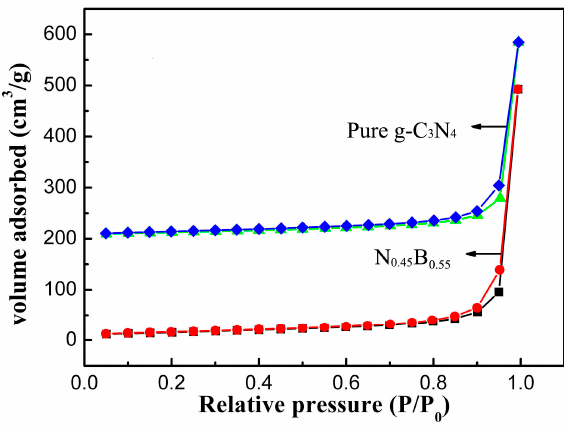
Figure 5. Nitrogen adsorption-desorption isotherms of the as-obtained g-C 3 N 4 and N 0.45 B 0.55 samples.